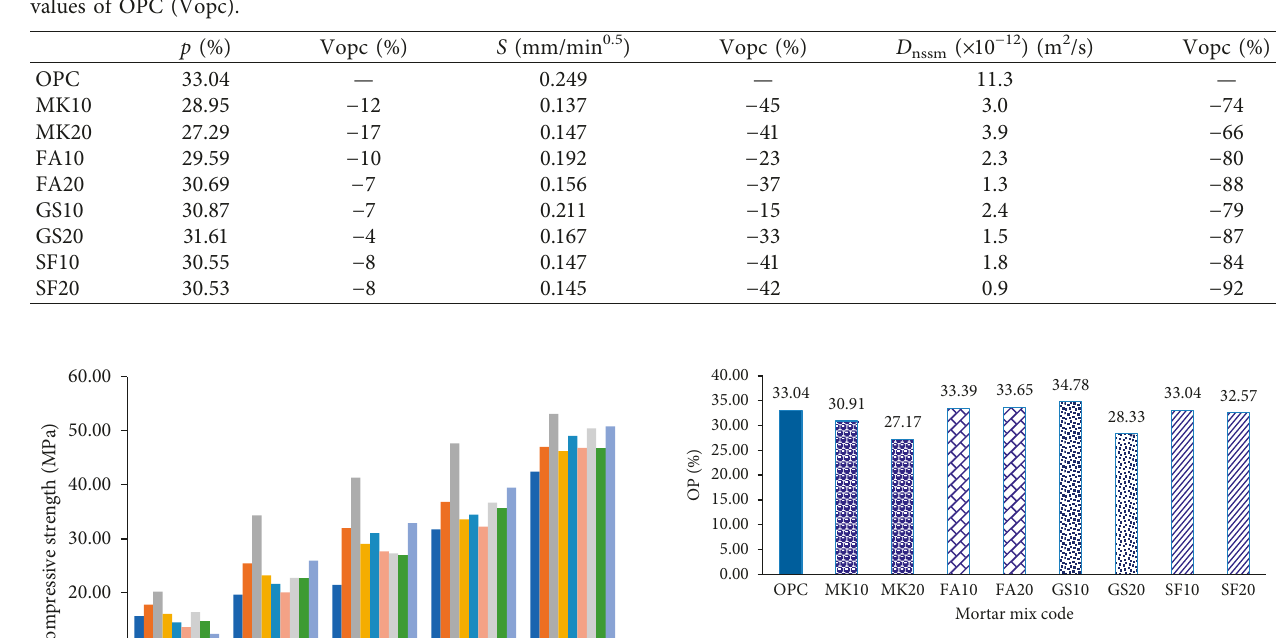
nssm ) results, and their variance from their counterpart